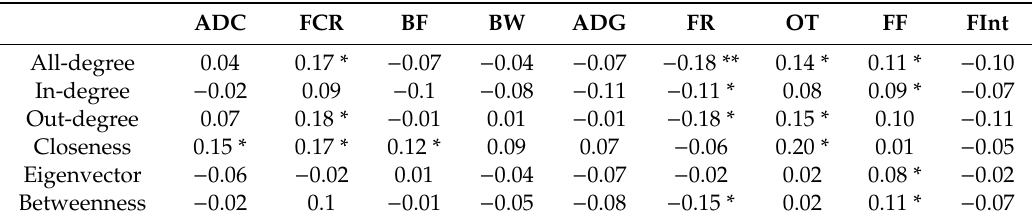
Table 5. Spearman rank correlations of individual agonistic behaviour scores from social network analysis with feed e ffi ciency, growth and feeding behaviour